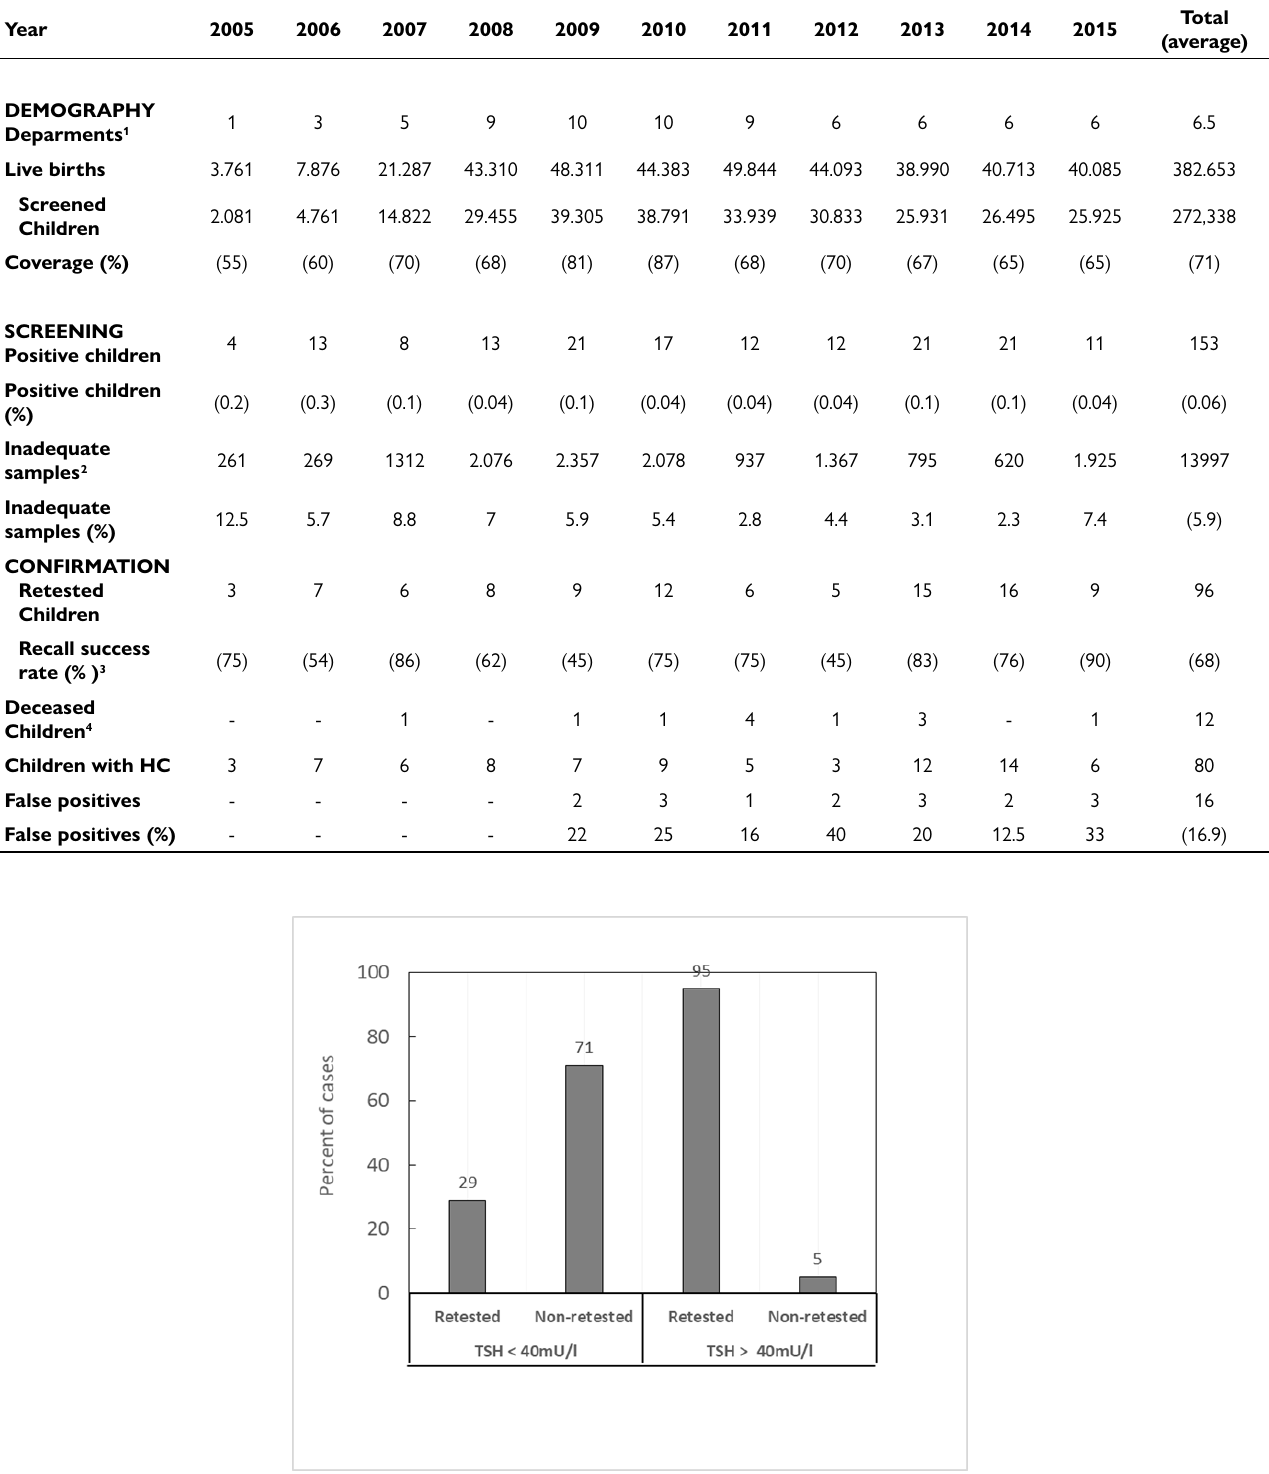
Table 1. Characteristics and results of the neonatal screening for CH in Nicaragua over a period of 10 years (2005-2015). ¹ Number of Nicaraguan Departments participating in the screening program per year. 2 Inadequate samples for TSH determination due to faulty technique in cord-blood sample collection. 3 The percentage of children retested in serum for CH confirmation does not consider children who died before serum confirmation test. 4 Children deceased before recall for serum confirmation of CH.